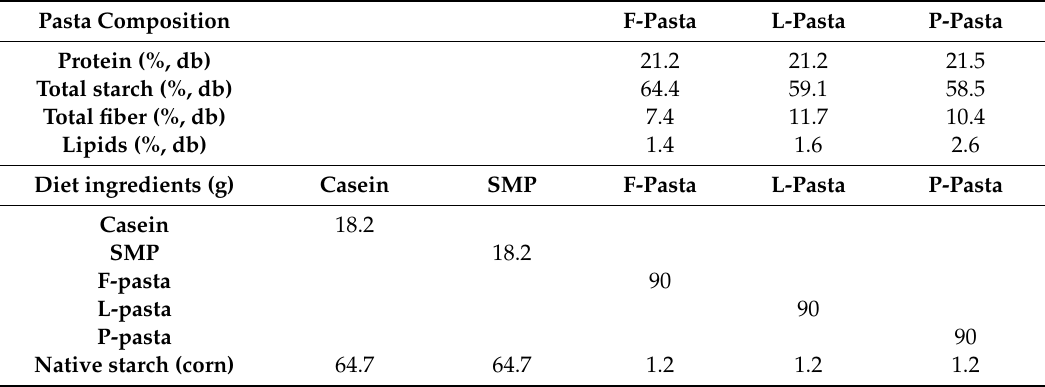
Table 1. Chemical composition of legume-enriched pasta and experimental